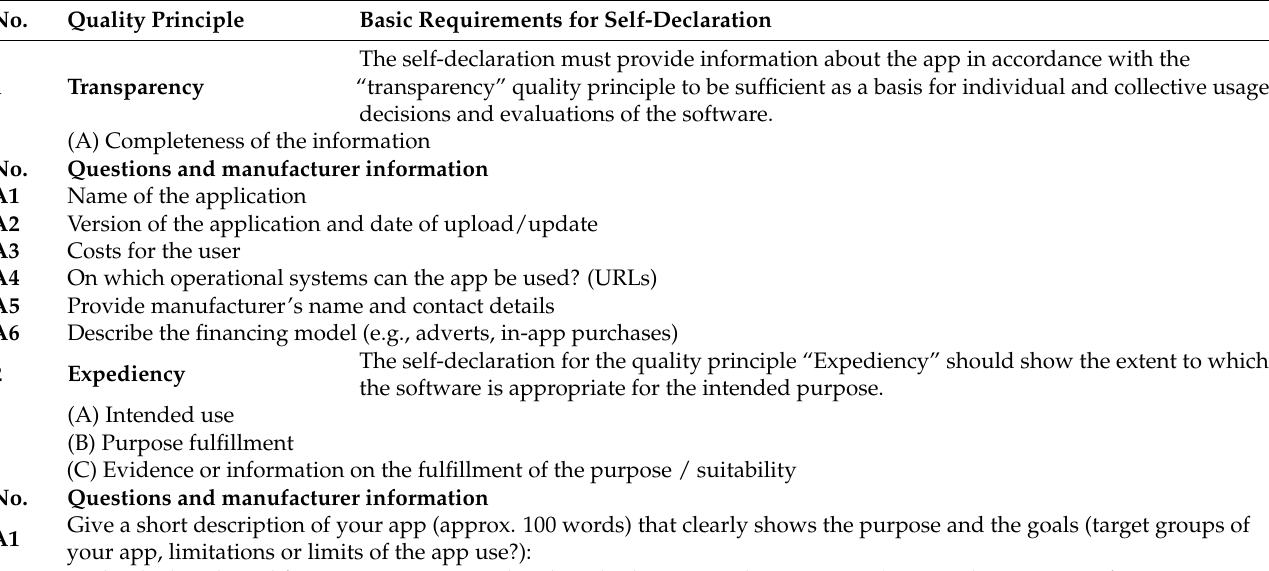
Table 2. Self-declaration sheet for app manufacturers. Application for acceptance of the app